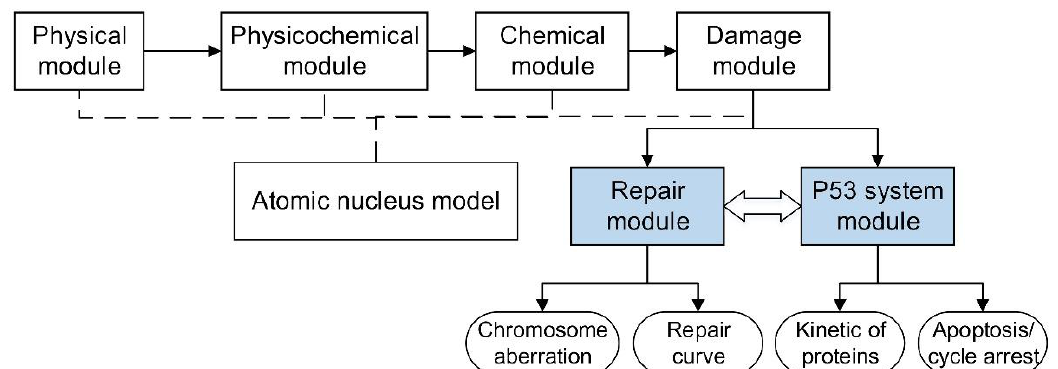
Figure 7. Scheme of the simulation modules within NASIC. The new modules added in this study are filled with blue shading.